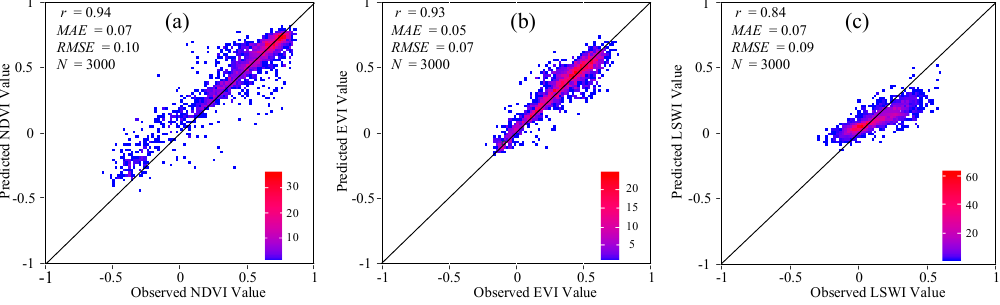
Figure 7. Comparison between fused Landsat–MODIS data produced by the ESTARFM method and real data in 3000 random samples. ( a – c ) The values of NDVI, EVI, and LSWI, respectively.